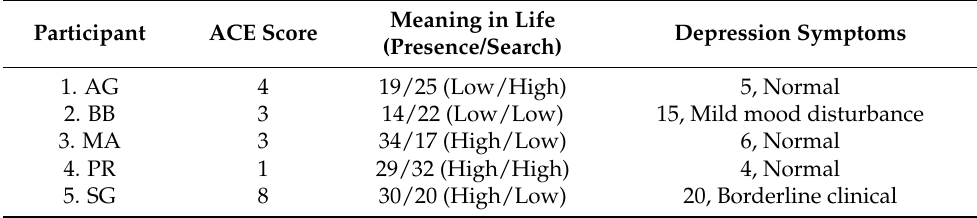
Table 3. Descriptive results of ACE, meaning in life, and depression symptoms.